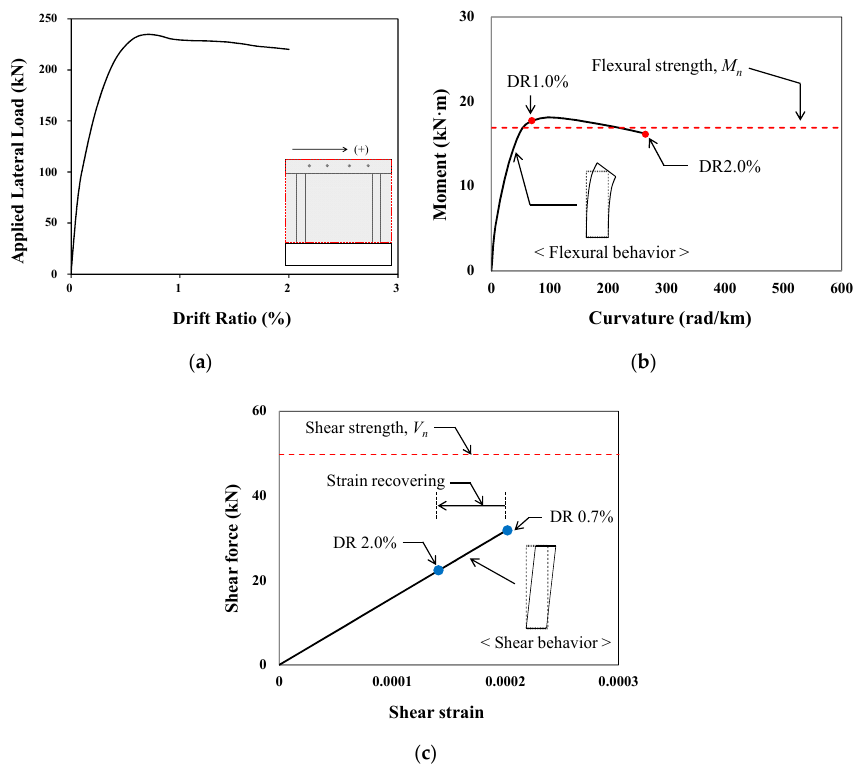
Figure 16. Flexural and shear behavior of column element in Specimen FB: ( a ) pushover; ( b ) flexural behavior; ( c ) shear behavior.